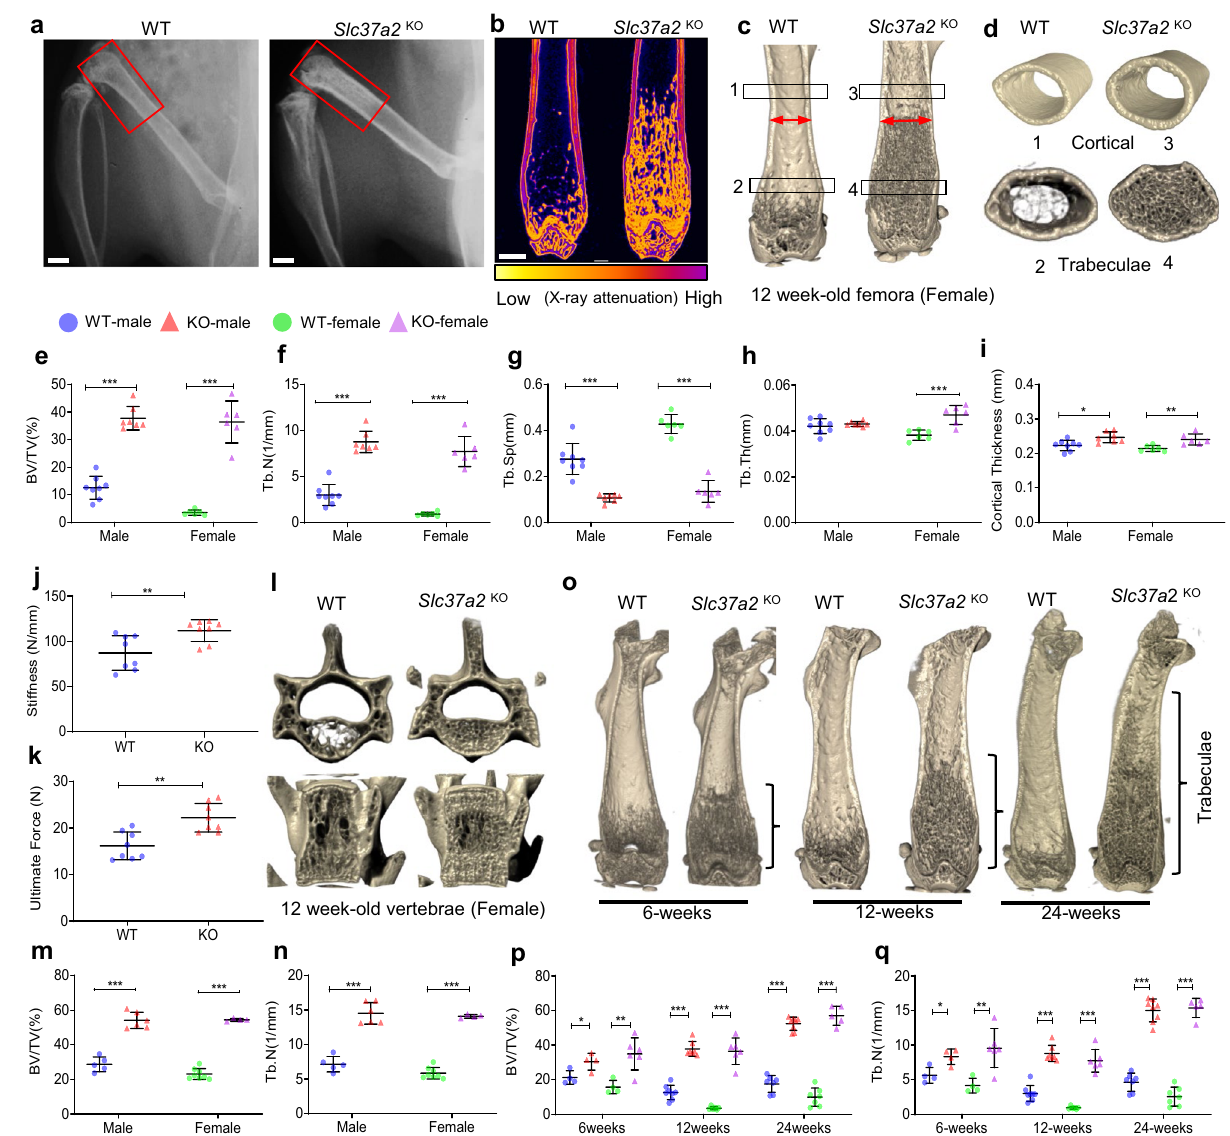
Fig. 5 | Slc37a2 KO exhibits high bone mass and increased bone strength. a Radiography of the hindlimbs of 12-week-oldfemale WTand Slc37a2 KO mice. Bar, 1mm. b – d Representative sagittal µ CT section false-colored to indicate X-ray attenuation ( b ) and µ CT 3D reconstructed images of sagittal ( c ) and transverse ( d ) sections of distal femurs of 12-week-old female WT and Slc37a2 KO mice. e – i µ CT analysisoffemursof12-week-oldmaleandfemaleWT( n =8maleand6female)and Slc37a2 KO ( n =7 male and 6 female)mice. e Male P <0.0001 and female P <0.0001. f Male P <0.0001and female P <0.0001. g Male P <0.0001 and female P <0.0001. h Male P =0.7874, female P <0.0001. i Male P =0.0114, female P =0.0053. j and k Biomechanical three-point bending test of 12-week-old male WT and Slc37a2 KO femurs. Stiffness ( j , P =0.0083) and ultimate force ( k , P =0.0013) are presented ( n =8 mice per genotype). l – n Representative µ CT images of vertebrae ( l ) and µ CT analysisofvertebrae( m and n )of12-week-oldmaleandfemaleWT( n =5maleand8